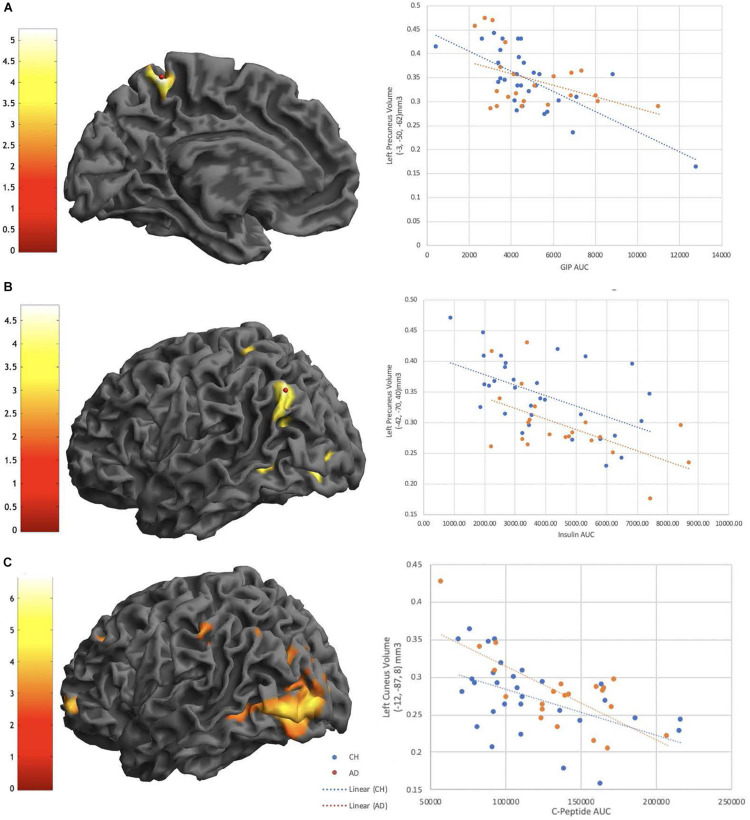
GIP AUC (A), Insulin AUC (B), and C-Peptide AUC (C) are significantly negatively correlated with interior left precuneus (A), Left precuneus (B), and Left Cuneus volume (C) all in the parietal cortex. Extracted volumes plotted post-hoc against hormone AUC in plots on the right.